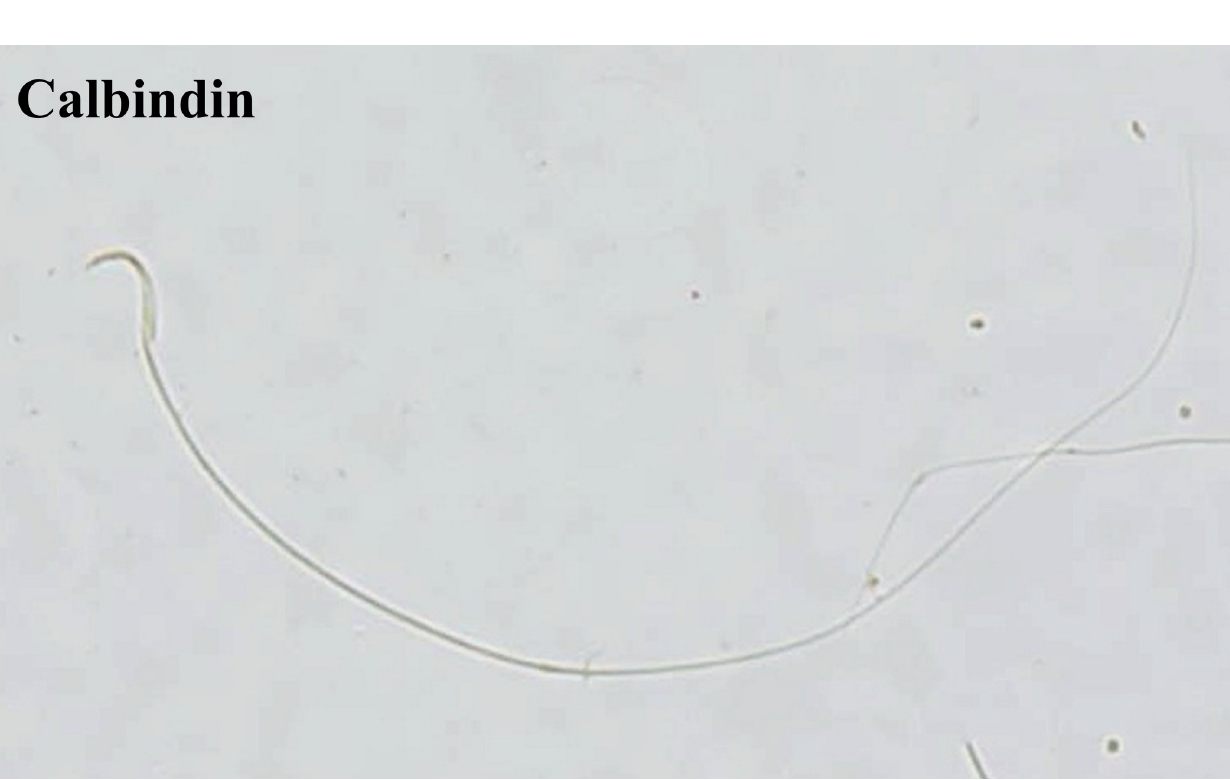
PLOS ONE | https://doi.org/10.1371/journal.pone.0273888 January 4, 2023 12 /